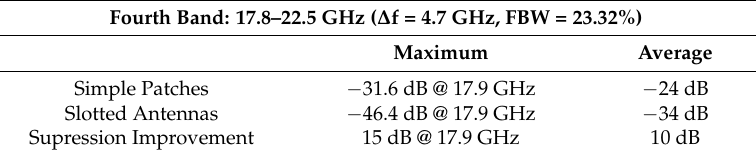
Table 4. Isolation in the third Ku-band and K-band.